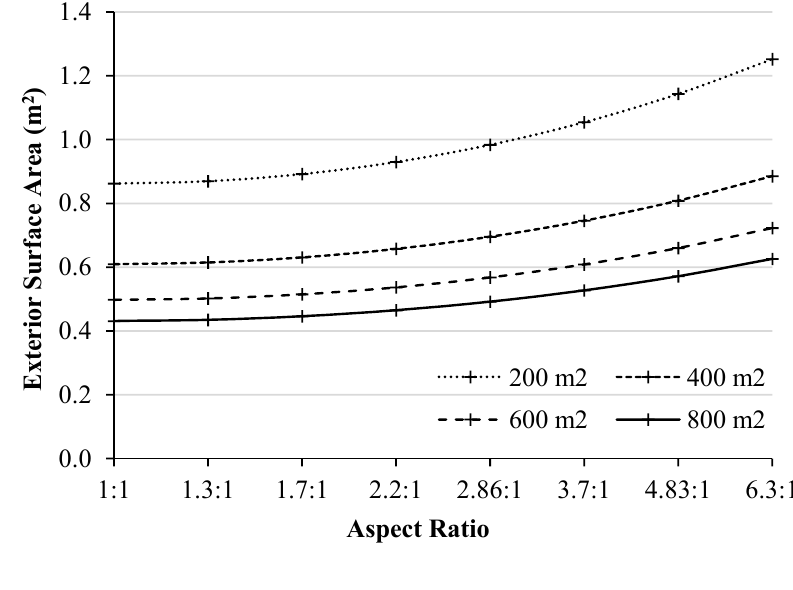
Figure 5. Exterior wall surface area per square meter of floor area for various building footprints with an assumed floor to floor height of 3